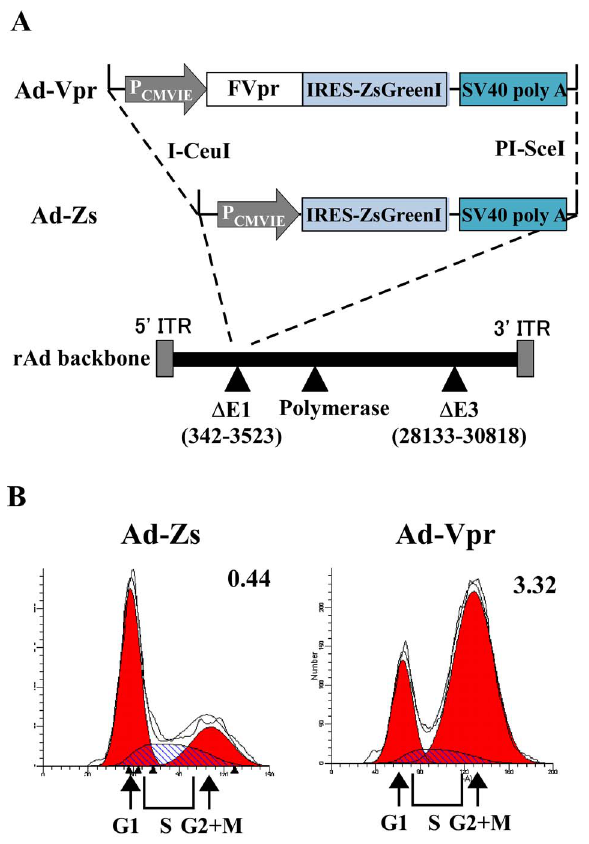
Figure 1. Schematic diagram of the Ad-Vpr and Ad-Zs vectors and analysis of their functional expression. (A) Recombinant adenovirus vectors expressing either FLAG-Vpr and ZsGreen1 or ZsGreen1 were generated using the Adeno-X TM expression system, as described in Materials and Methods. The transgene cassettes that replace the deleted E1 region contain a cytomegalovirus (CMV) promoter driving the expression of FLAG-Vpr and ZsGreen1 or ZsGreen1 protein, followed by an SV40 polyadenylation signal. The solid triangles indicate the regions deleted in the recombinant adenovirus (rAd) backbone. ITR: Inverted terminal repeats. (B) HeLa cells were infected with Ad-Vpr or Ad-Zs at MOI 50. At 48 h post- infection, cells were fixed and stained with propidium iodide for the analysis of DNA content. ZsGreen1-positive cells were analyzed by flow cytometry using Cell Quest for acquisition and ModFit LT. Arrowheads indicate peaks representing cells in the G1 and G2 + M phases. The G2 + M: G1 ratio is indicated in the upper right of each